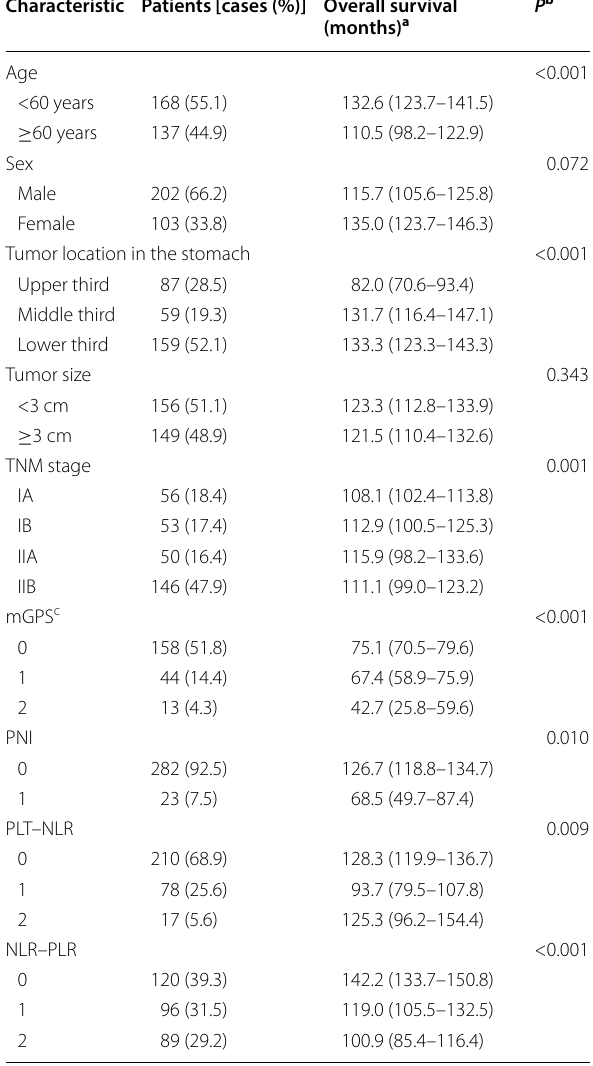
Table 1 Clinical and laboratory characteristics as well as overall survival of the 305 patients with stage I–II gas- tric cancer after resection